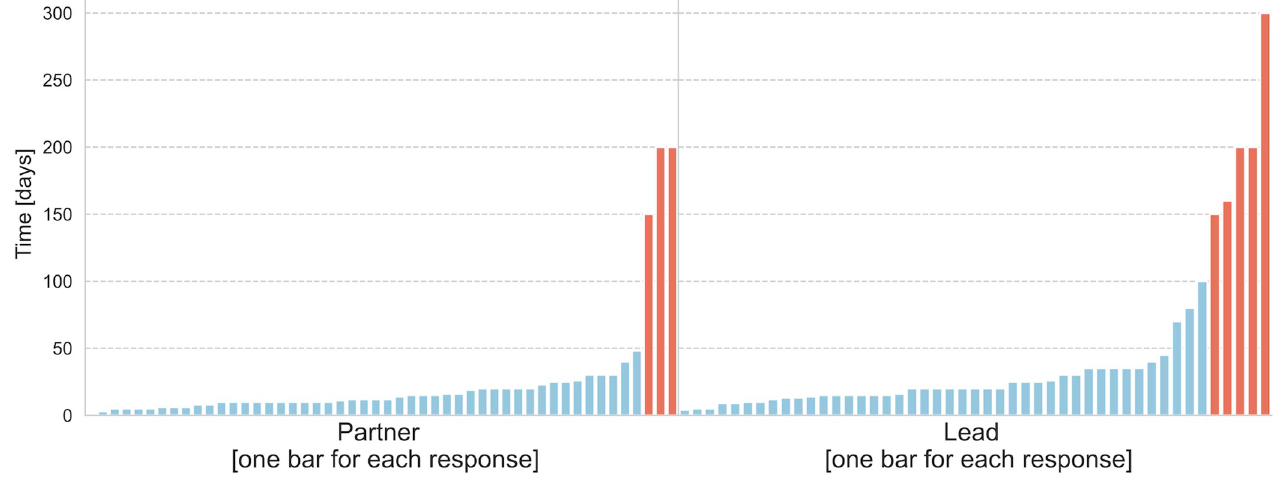
Fig 5. Responses to the question “How much time in days did your organization spend working on the proposal overall (including your days)?”.